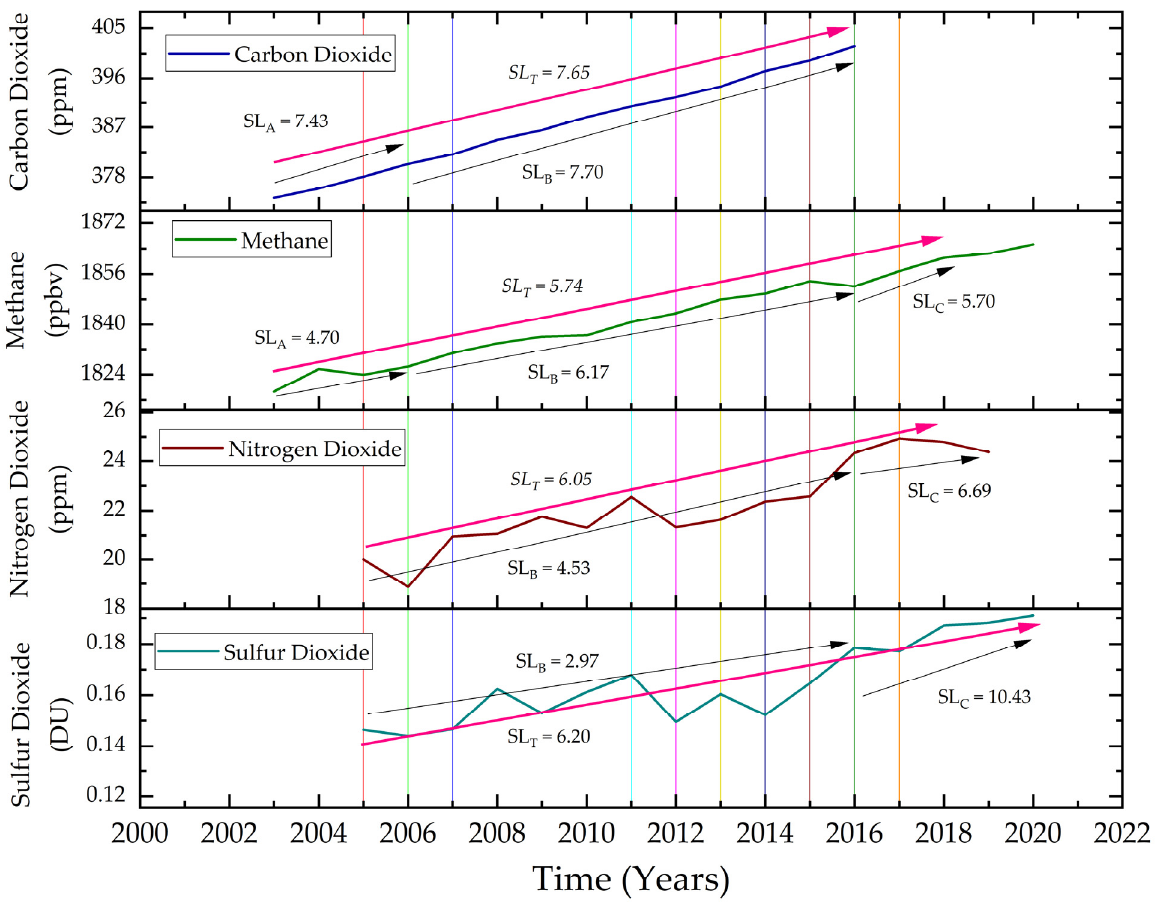
Figure 4. Long-term pollutant variation with respect to TPPs. The straight lines mark the installation of the new TPP. Details of new thermal power plants established are as follows: 2 in 2005, 1 TPP in 2006 and 2007, 4 in 2012, 4 in 2013, 4 in 2014, 3 in 2015, 2 in 2016 and 1 in 2017. It can be observed that CO 2 and CH 4 have been on a continuous rise since